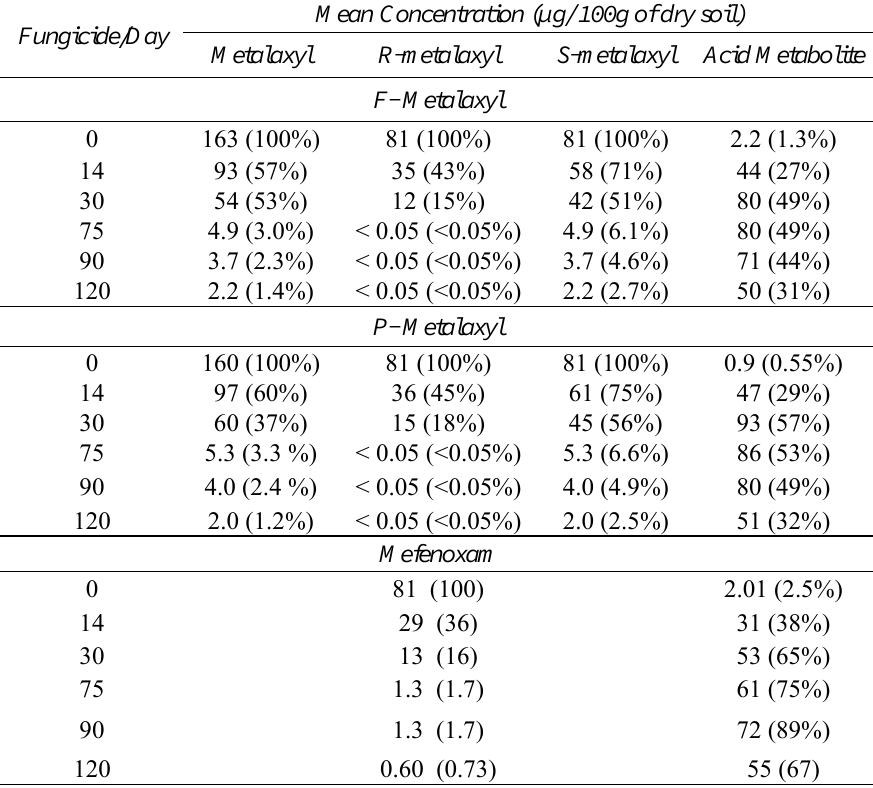
Table 3: Concentrations of metalaxyl and its enantiomers as well as the metabolite in the German soil after the respective incubation intervals.